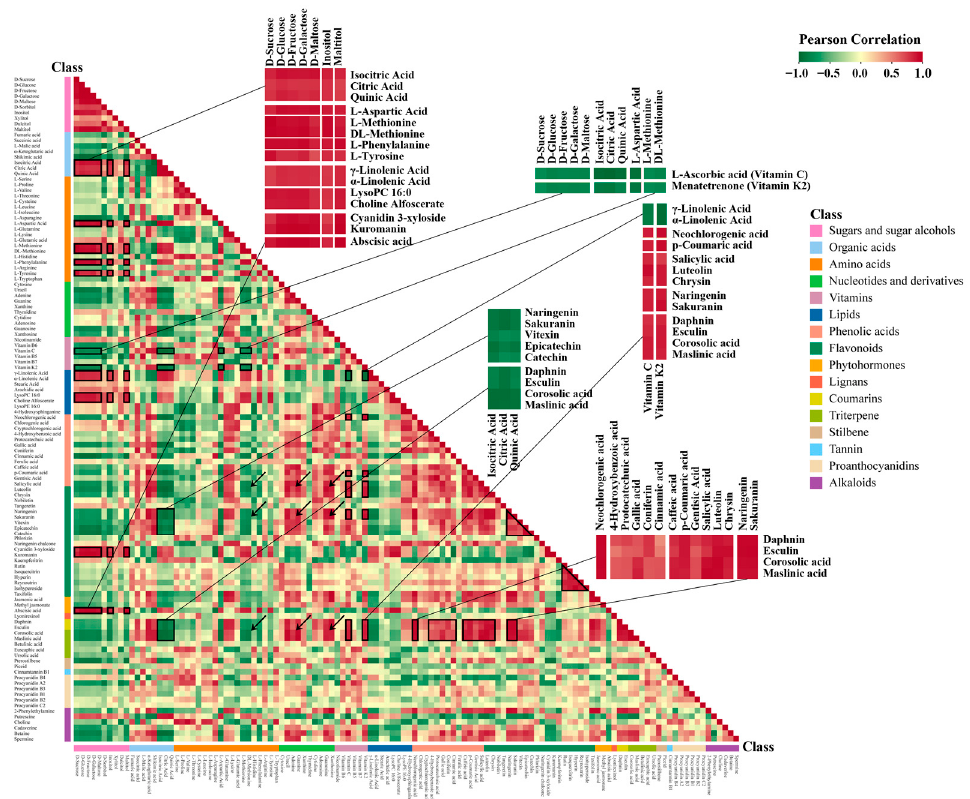
Figure 8. Heat map of correlations between metabolites. For this correlation analysis, 120 representative metabolites were selected from among 998 metabolites. The Pearson algorithm in R software was used to obtain metabolite–metabolite correlation coefficients. Each square of the heat map represents the correlation coefficient score derived from the Pearson analysis between metabolites located in the corresponding row and column. The 120 representative metabolites used for correlation analysis are listed in Table S2, and the correlation coefficient scores between metabolites are shown in Table S3. Information on correlations between some of the important metabolites is marked by black boxes and enlarged in the figure. Significant correlations between amino acids, nucleotides, and secondary metabolites are marked by black arrows.